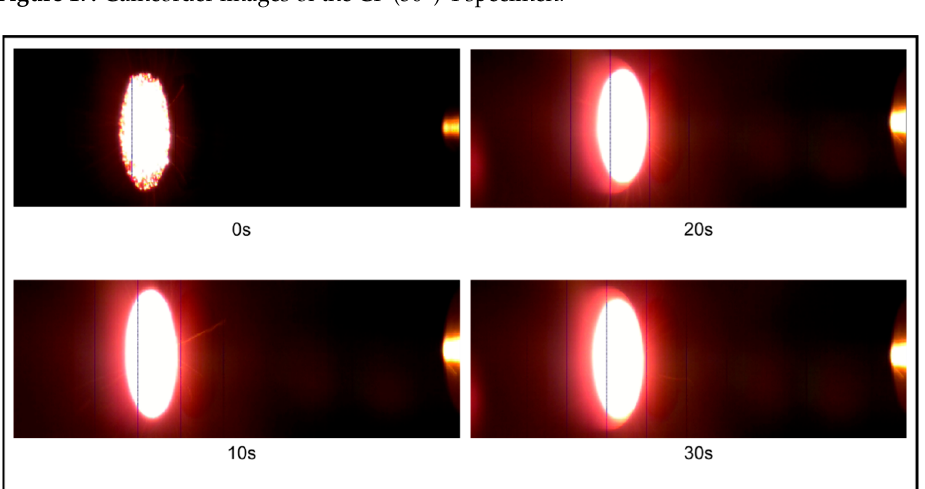
Figure 18. High-speed camera images of the CP (30°)-4 specimen.